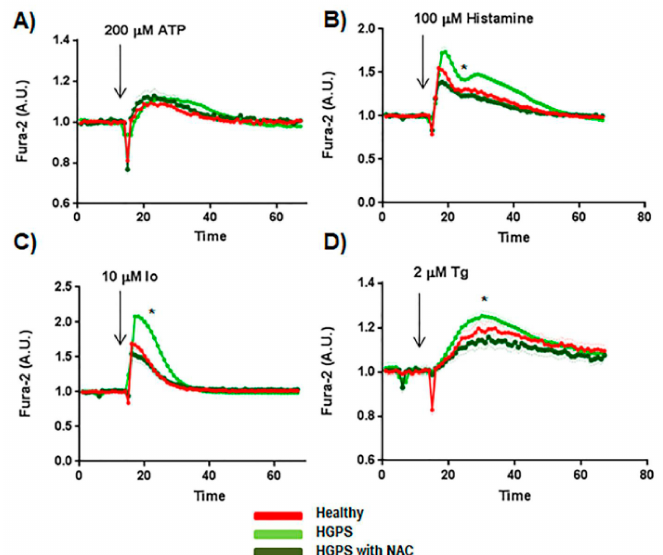
Figure 4. Cytosolic calcium handling study using NAC. ( A ) Ca 2+ flux in the absence of extracellular calcium with 3 mM of EGTA in the medium was performed using healthy (AG03257, AG03258, AG03512, and AG06299) and HGPS (AG03198, AG03199, AG03513, and AG06917) human skin fibroblasts in a FlexStation reader. Some experiments were performed by adding NAC at 10 µ M for one hour in the medium with HGPS cell line plates. ( B ) Results after adding ATP at 100 µ M (arrow). ( C ) Results after adding 10 µ M ionomycin (Io) (arrow). ( D ) Results after adding 10 µ M thapsigargin (Tg) (arrow). Bars are means ± SEM from three independent experiments. * p < 0.001 was considered statistically